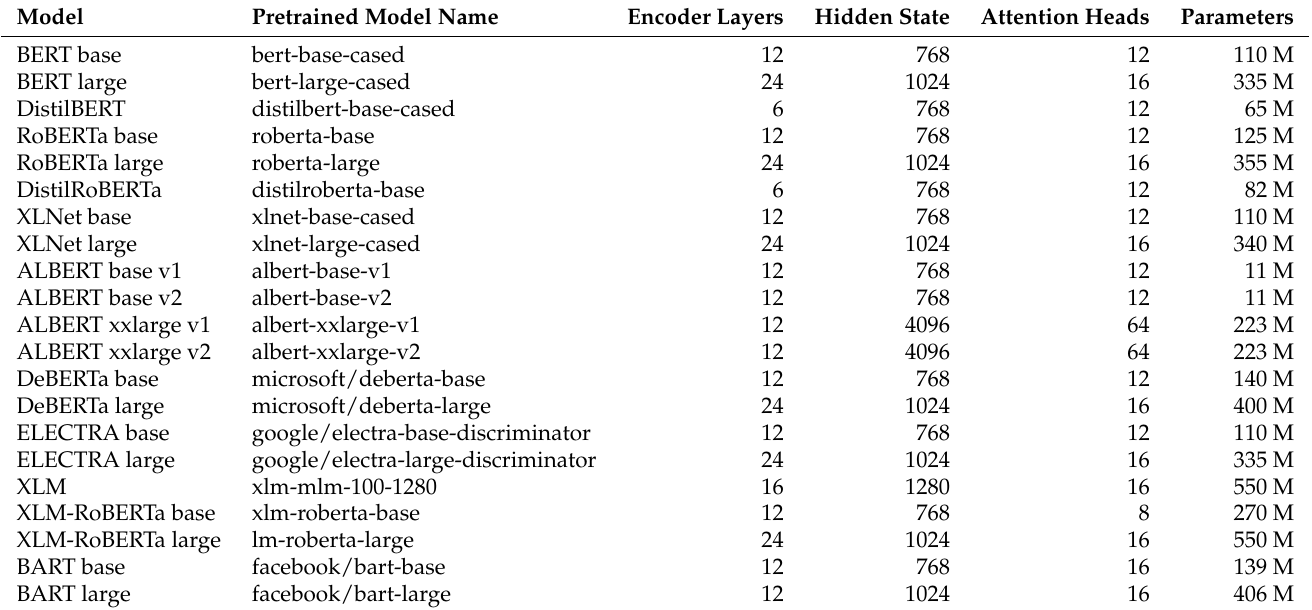
Table 5. Transformer